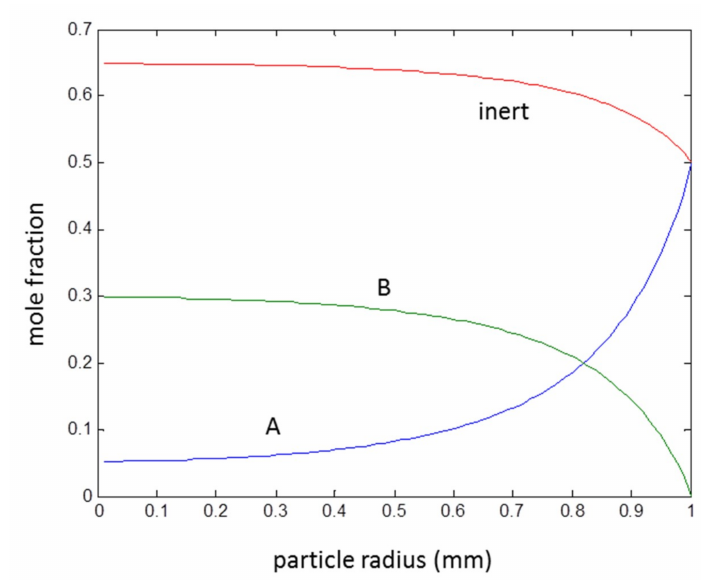
Figure 5. Composition profiles for second order elementary reaction 2A → B with inert compound.